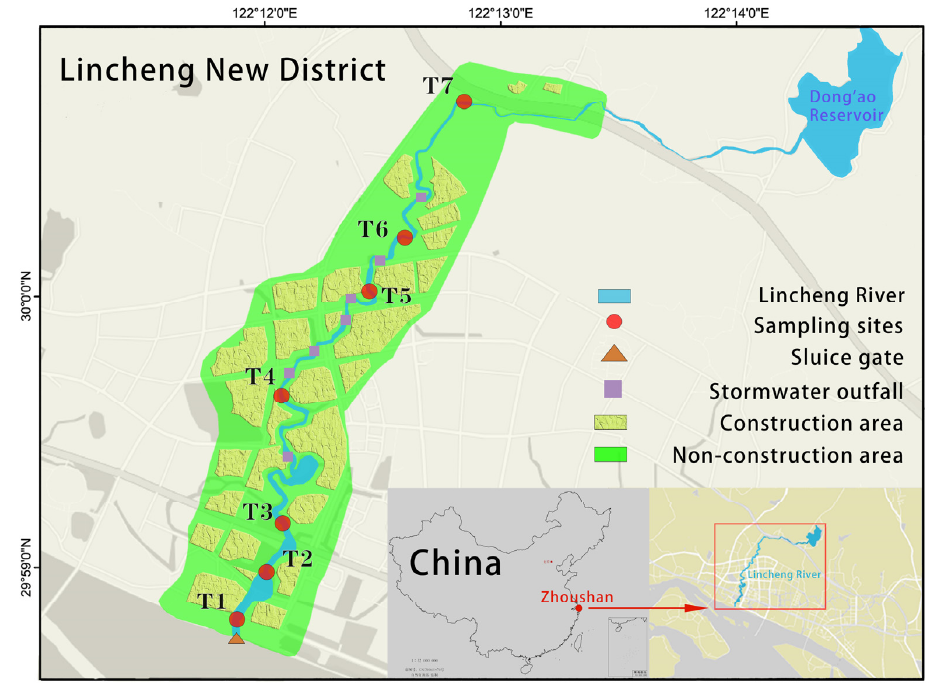
Figure 1. Sampling sites in the Lincheng River.